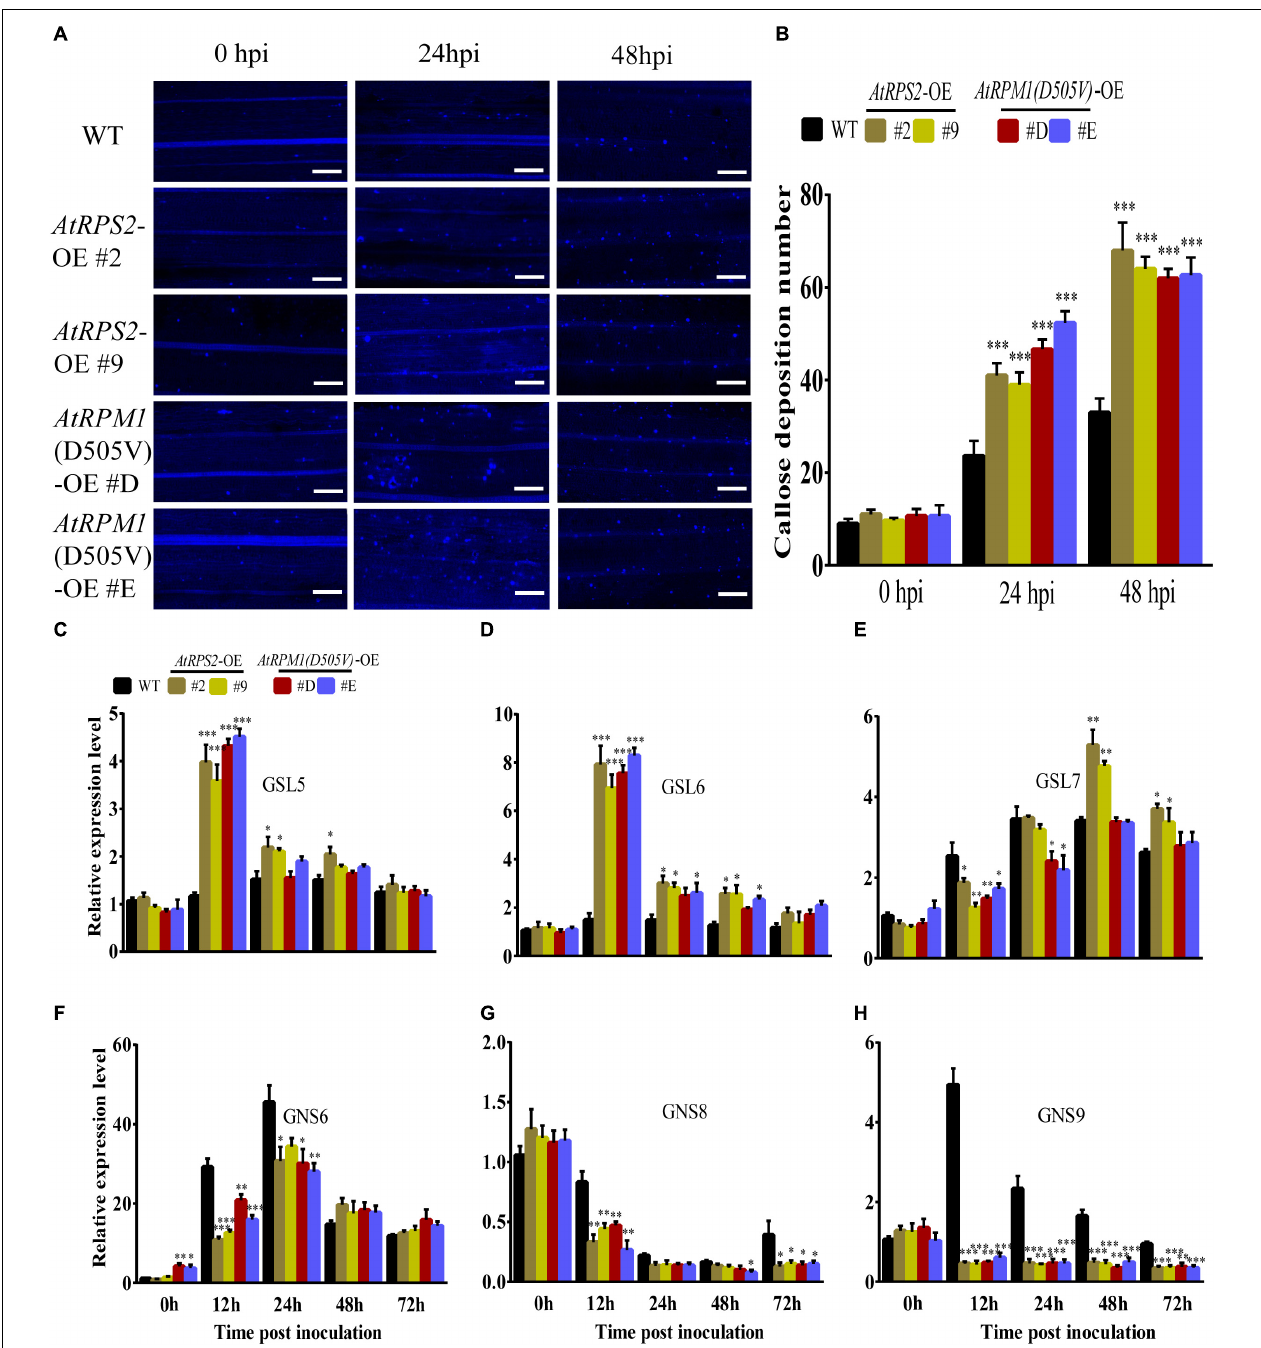
FIGURE 5 | AtRPS2 and AtRPM1 ( D505V ) Promote Callose Deposition During M. oryzae Infection. (A) Callose depositions were obviously increased in the transgenic plant cells compared with the Nipponbare cells at 24 and 48 hpi. Scale bars = 50 µ m. (B) Mean values of the callose deposition number. Data are shown as means ± SD ( n = 5). (C–H) Expression analysis of callose synthase genes and callose hydrolase-encoding genes upon M . oryzae infection. The OsActin gene was used as an internal control. Gene expression levels were normalized to 0 h of Nipponbare. Data are shown as means ± SD ( n = 3). Asterisks denote significant differences (one way ANOVA, ∗ P < 0.05, ∗∗ P < 0.01, ∗∗∗ P < 0.001). Similar results were obtained in three independent experiments.